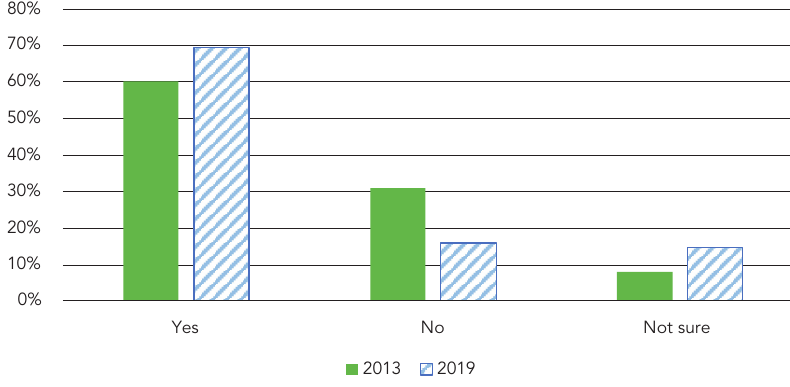
Chart 6: Norms/Morality: If widespread wildlife extinctions are unavoidable without slowing human population growth, do you think our society has a moral responsibility to address population